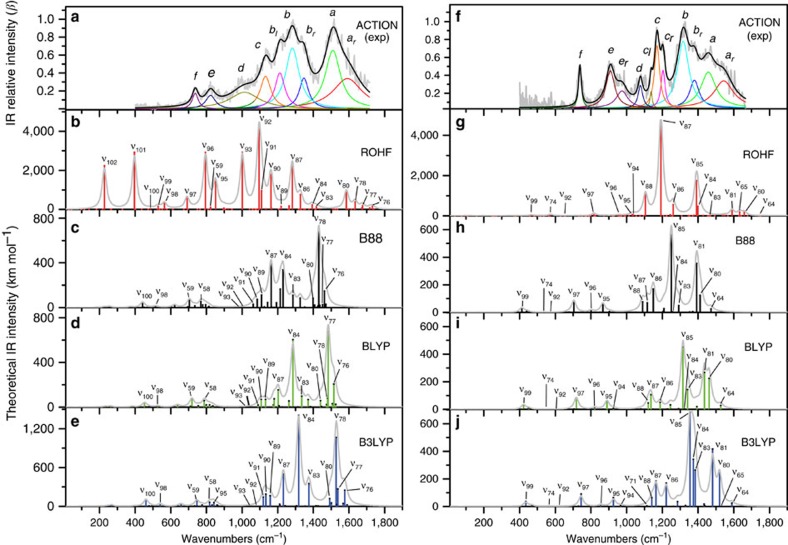
Harmonic mode analysis as a function of electronic correlation.The resultant final action spectra (grey) converted to spatial frequency wavenumbers (cm−1) of (a) picene+ and (f) pentacene+. The spectral deconvolution band fitting based on the Levenberg–Marquardt algorithm results, respectively, for picene+ and pentacene+, in 9 and 11 Lorentzian band peaks (each correspond to a lower case letter), which cumulative peak spectral curve is depicted in black. In Table 1 resultant peaks are summarized and sequentially numbered from ar to f in correspondence with action band features. Theoretical linear harmonic spectra (generated by convoluting scaled normal modes with a Lorentzian 30 cm−1 function) are based on ROHF (b, picene+ and g, pentacene+) and B88, BLYP and B3LYP density functionals (see Methods, mode assignations in Supplementary Tables 7–16 where B is B88) for c–e, picene+ and h–j, pentacene+.